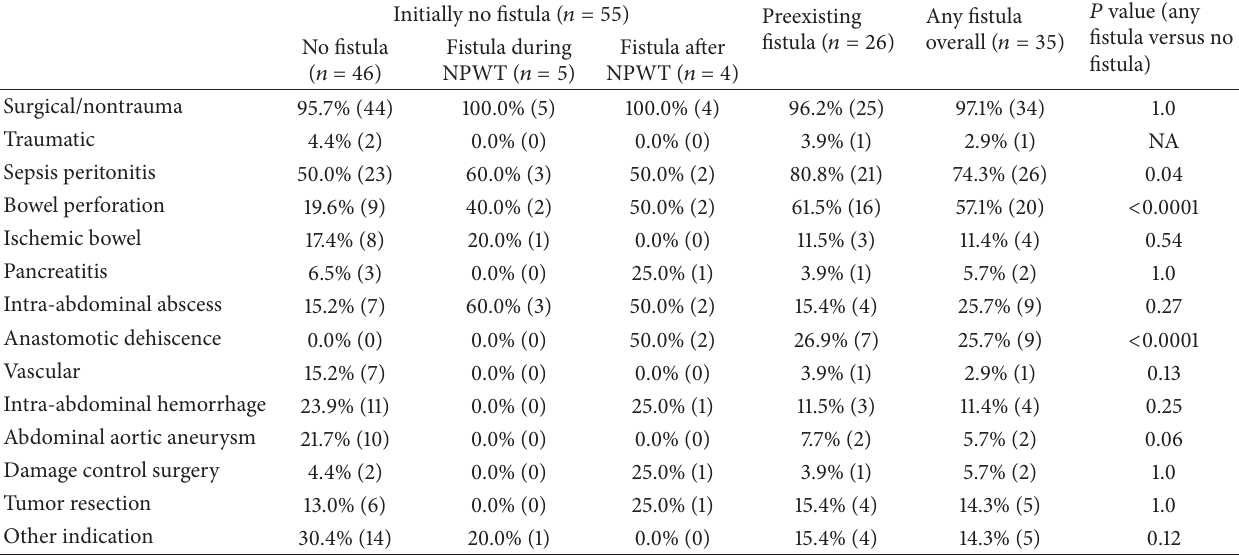
Table 2: Indications for the OA.